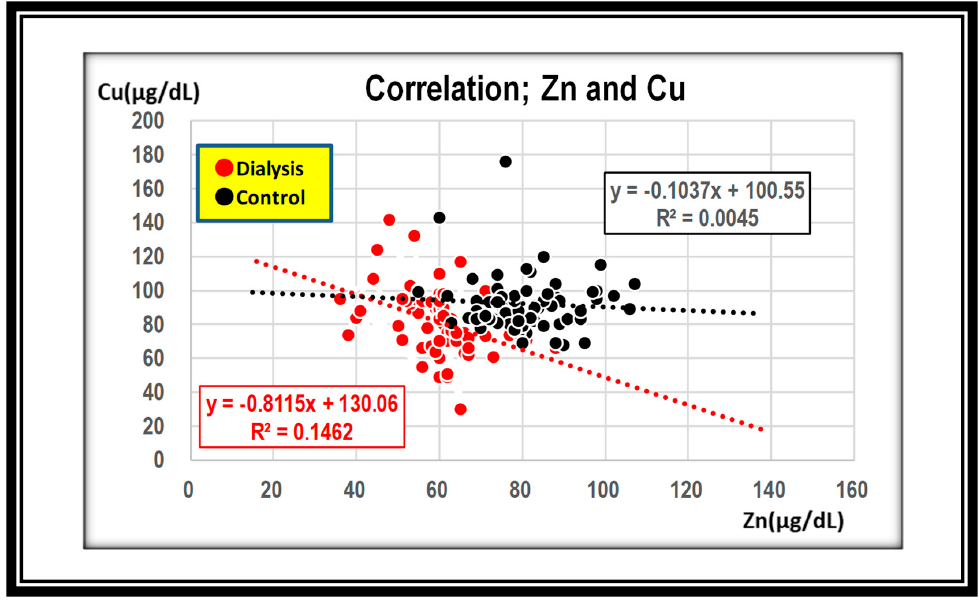
Figure 4. Zinc and copper values are negatively correlated in both groups. • ; dialysis group, • ; control group.